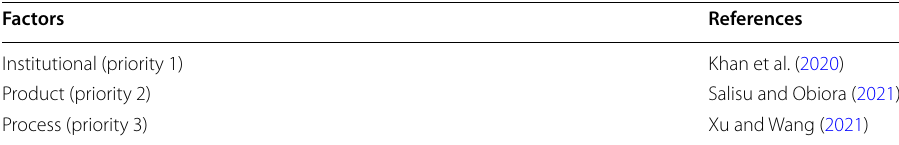
Table 5 Categories for financial innovation priorities